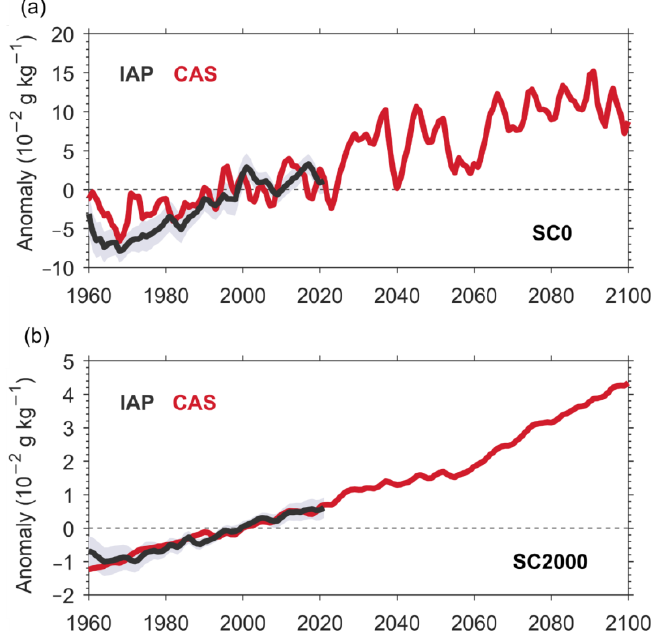
Figure 7. Time series of the global annual mean for ( a ) sea surface salinity (SSS) contrast and ( b ) 0-2000 m averaged salinity (S2000) contrast metrics as monitored from the IAP observation (solid black line) and as simulated by CAS-ESM2-0 in historical and SSP5-8.5 projections during 1960–2100 (solid red line). The gray shadings denote 2 times standard deviation of error range in IAP mapping framework. The color lines are the time series after applying the LOWESS (locally weighted scatterplot smoothing) smoother with a span width of 3 years.